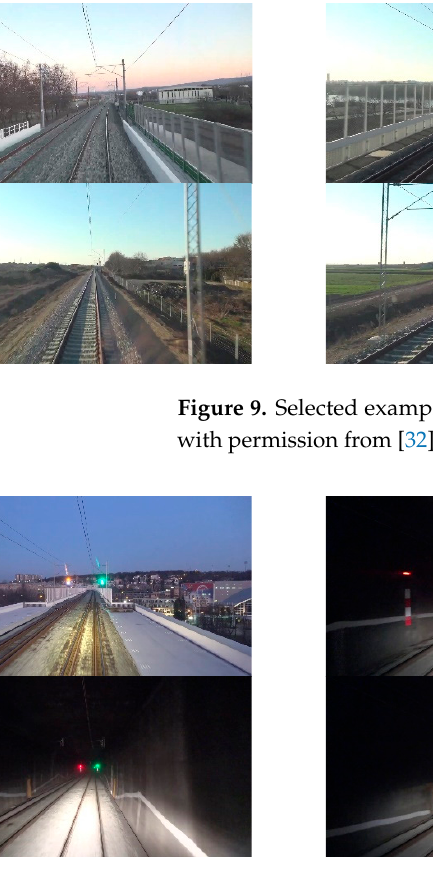
Figure 8. Selected examples of daily images—before evening (closer than 25 m from the camera). Adapted with permission from [32].